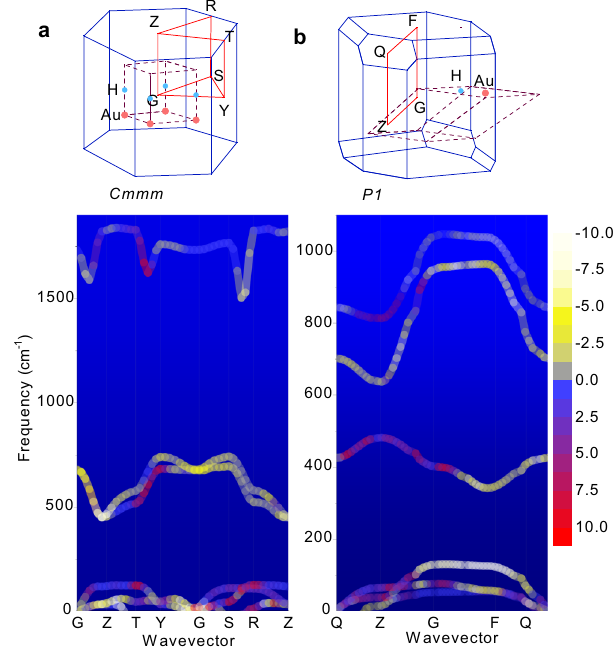
Fig. 3 Phonon dispersion curves for selected symmetries. a Cmmm and b P 1. The brighter (yellowish) colors show the larger negative mode Grüneisen parameters, whereas the darker ones (reddish) correspond to the larger positive values. The Brillouin zone (blue) path (red lines) with reciprocal lattice points and the real lattice (dash brown lines) with positions of Au and hydrogen are also given. For easier comparison with the observed Raman data the phonons are given in the unit of cm − 1 instead of the conventional unit of